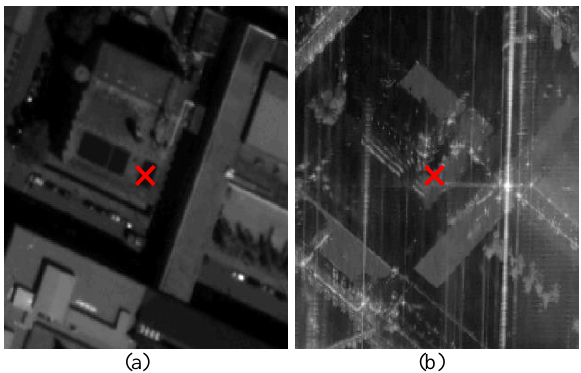
Figure 6. A different homologue area, which should be found to be similar in order to match the red crosses in the patch centers. It is obvious that similarity is much harder to be determined here than in the exemplary case illustrated in Section